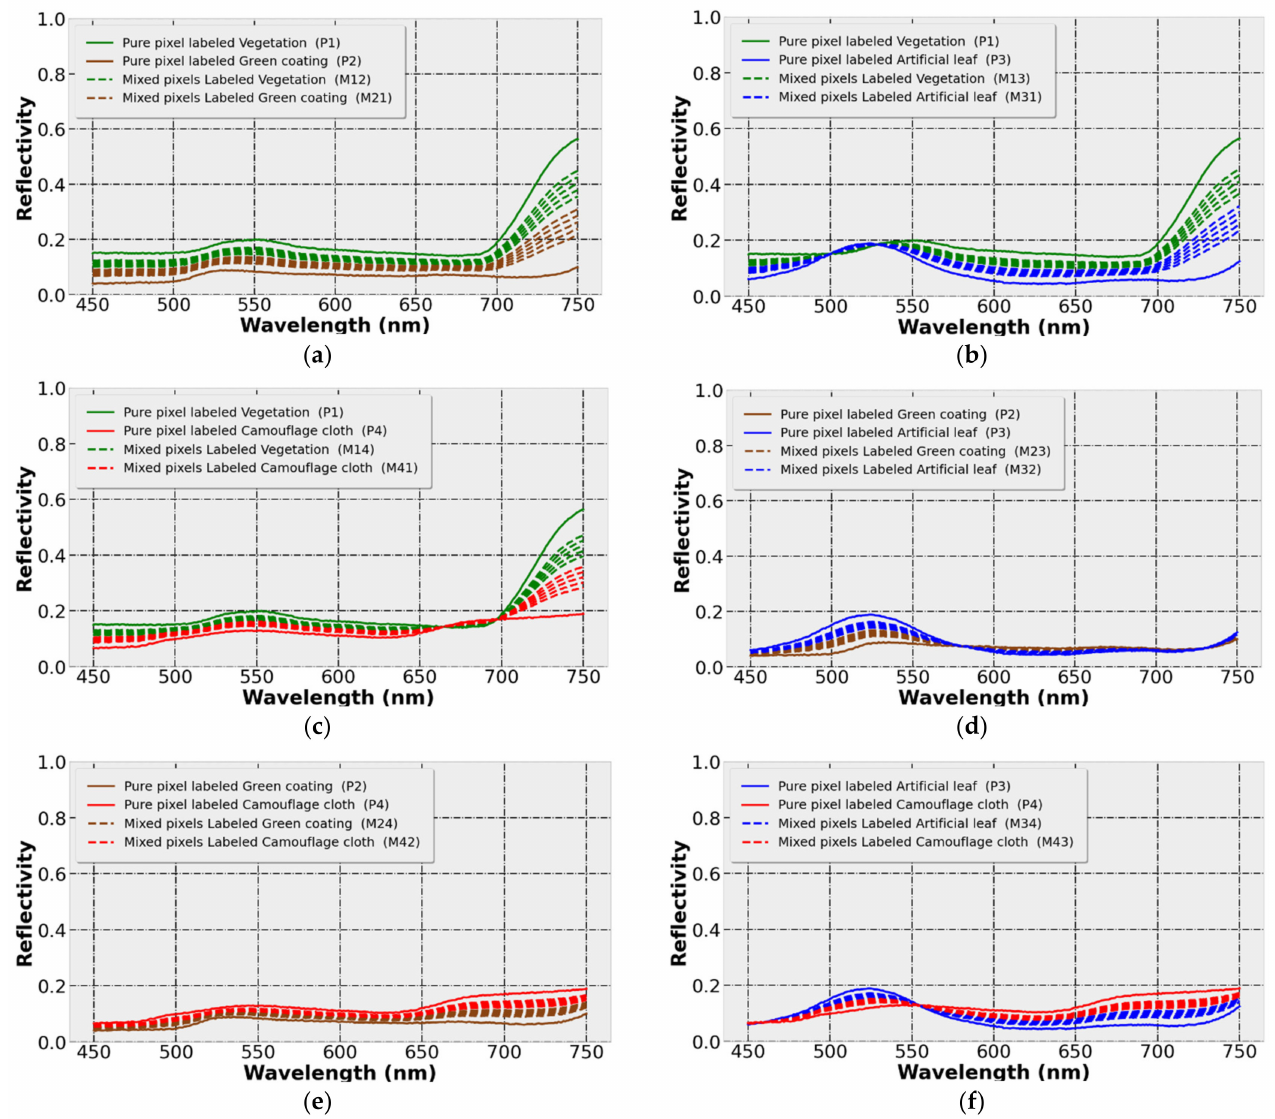
Figure 9. Spectral Characteristics of Hyperspectral Simulation Image Pixels (SNR = 1000): ( a ) veg- etation and green coating; ( b ) vegetation and artificial leaves; ( c ) vegetation and camouflage cloth; ( d ) green coating and artificial leaves; ( e ) green coating and camouflage cloth; ( f ) artificial leaves and camouflage